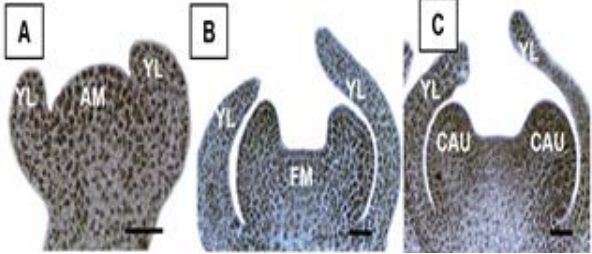
Fig. 2. Stage 1: Flower initiation (A, B) and Stage 2: CAU initiation (C) in M. sylvestris . A. Apical meristem. B. Floral meristem. C. Initiation of CAU. AM: Apical meristem, CAU: Corolla / androecium units, FM: Floral meristem, YL: Young leaf. Bar: 5 µm